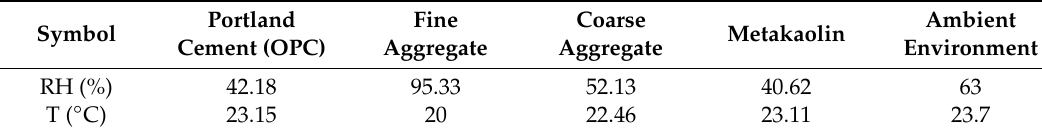
Table 1. Conditions of material components and ambient